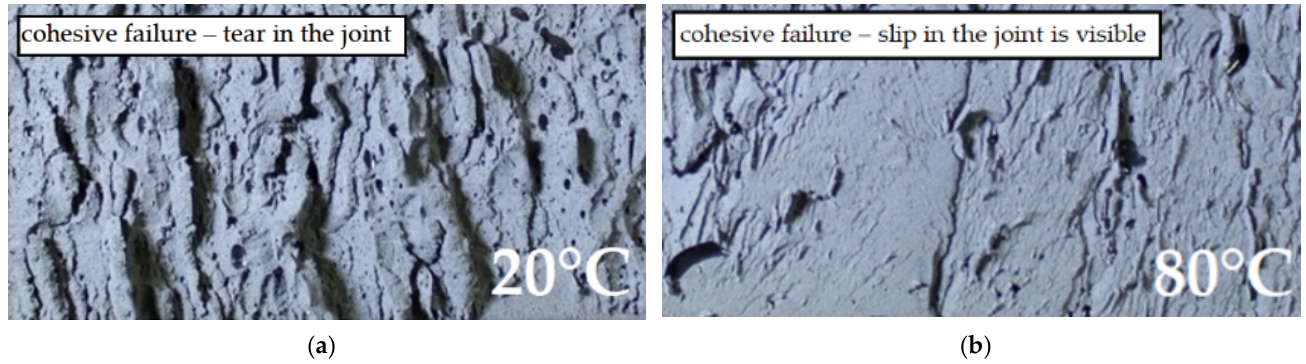
Figure 13. Failure type in the SikaPS epoxy adhesive joint: ( a ) at 20 °C; ( b ) at 80 °C. The double lap joints made with the EP 2579-1 epoxy experienced the destructive force decrease in relation to the temperature of 20 ◦ C by 76% for t = 1 mm, 72% for t = 2 mm and by 89%, respectively. In the t = 4 mm double lap joint, at 80 ◦ C the load capacity was reduced by almost 11% in comparison to the load capacity at 20 ◦ C. The analysis of the impact of joint thickness on the load capacity at 80 ◦ C indicates the load capacity decrease when the joint thickness increased in relation to the results for t = 1 mm (F max = 8.4 kN): by 26% for t = 2 mm, and by 42% for t = 4 mm, respectively. The failure form at 80 ◦ C was different. A cohesive failure in epoxy (cp) was observed. The differences in